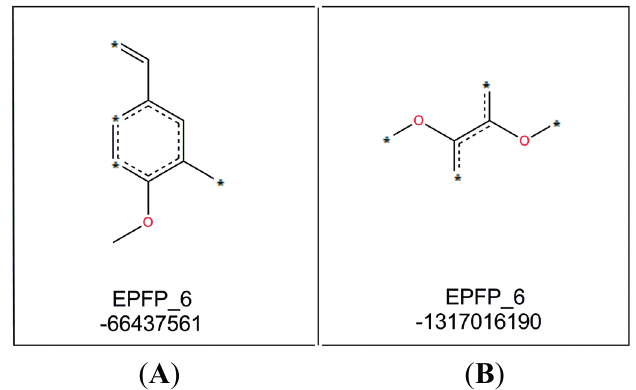
Figure 3. Molecular fragments generated by GFA